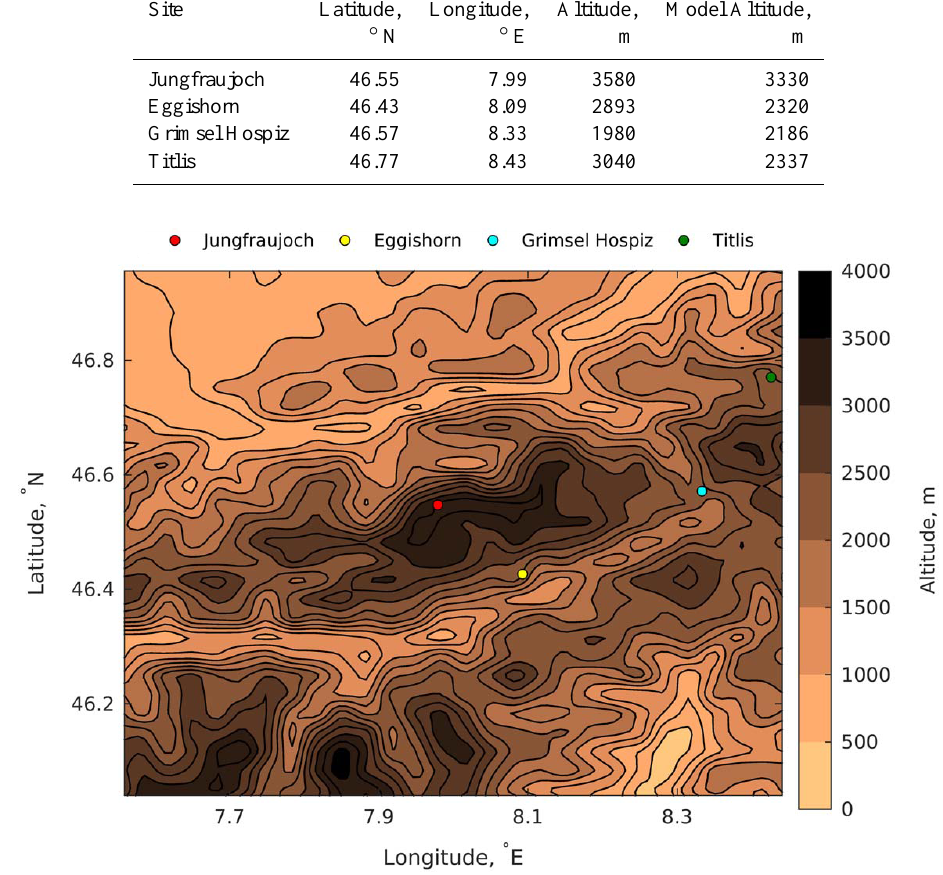
Figure 1. Location of MeteoSwiss observation